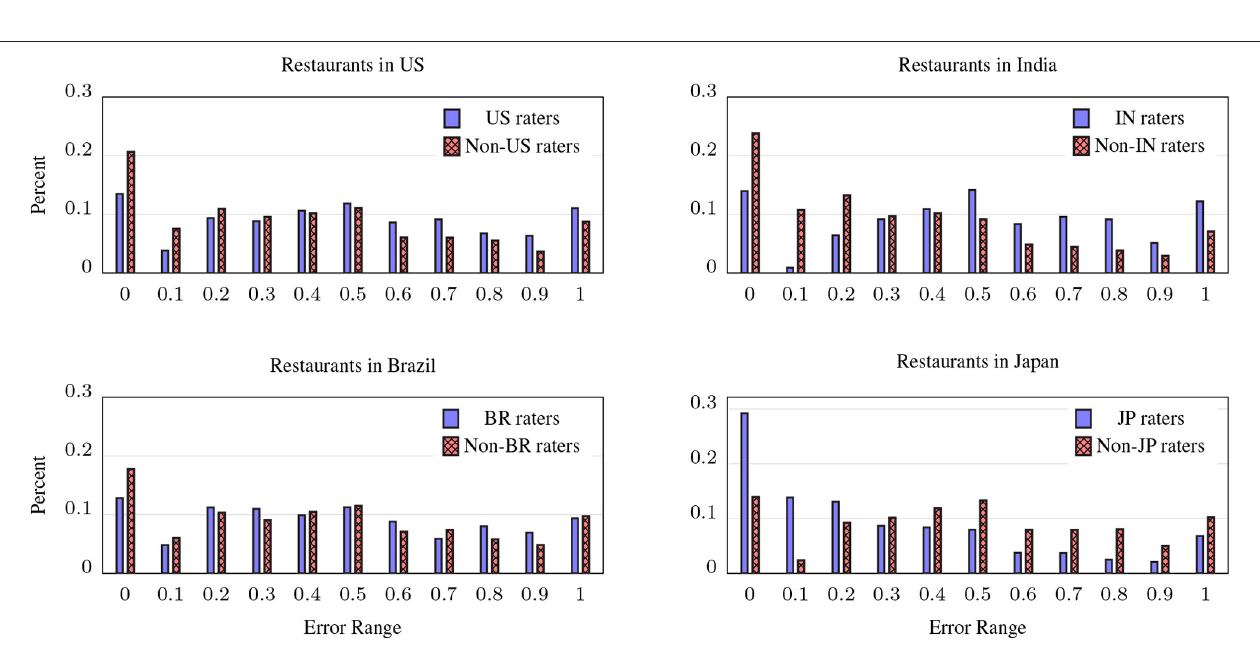
FIGURE 5 | Histogram of Normalized-MAE on CrowdSense pairs for three shopping and one dining (Section 5.5) class-level crowd task designs. Bins to the left indicate the relative number of pairs with lower error, making Shopping-PRODCAT the clear leader. Dining-MATRIX performs better than shopping MATRIX.